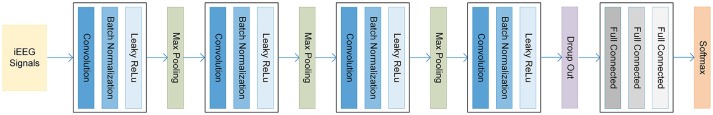
Architecture of our CNN model.